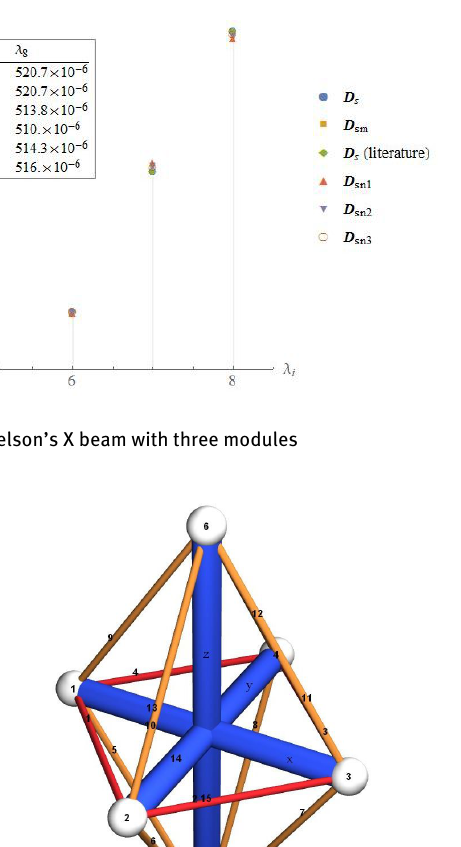
Figure 9: Octahedral cell, perspective view. Thick cylinders repre- sent the struts. Different colours have been assigned according to the value of the internal forces in the elements, which are labelled according to the connectivity matrix